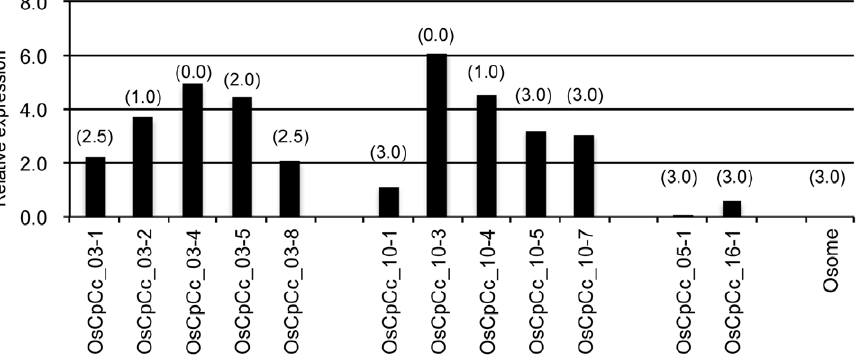
Figure 6. Expression of the Crr1a G004 transgene in T 1 lines inoculated with Ano-01. Transcript levels of 5 representative T 1 plants derived from each of 2 resistant T 0 lines and 1 plant derived from each of 2 susceptible T 0 lines are shown. Osome is the recipient. The disease index of each plant is indicated in parentheses above each bar. Similar results were obtained in 2 independent tests.